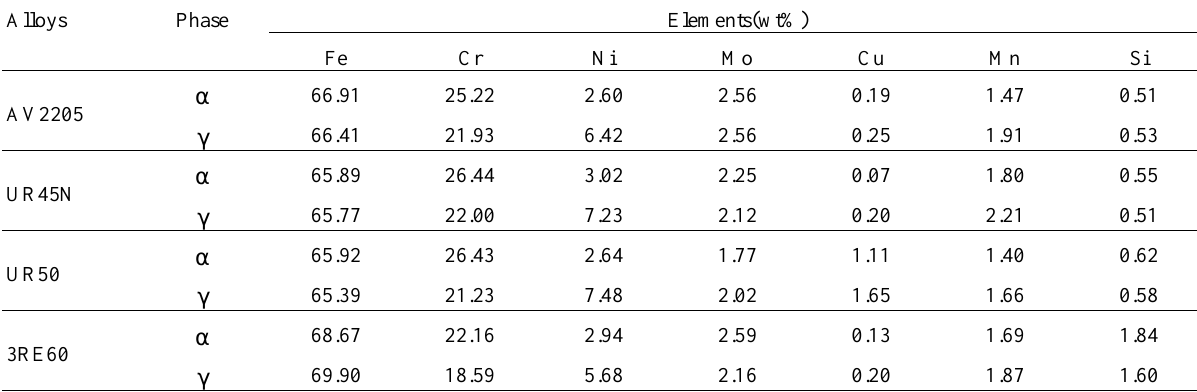
Table 7. Chemical composition of α , γ and σ phases in the alloys heat-treated at 850 °C for 5 h. Alloys Phase Elements (wt%) Fe Cr Ni AV2205